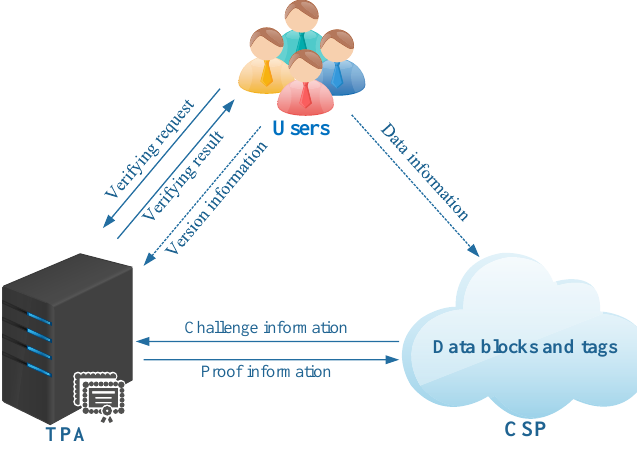
Figure 1. The system model for the proposed